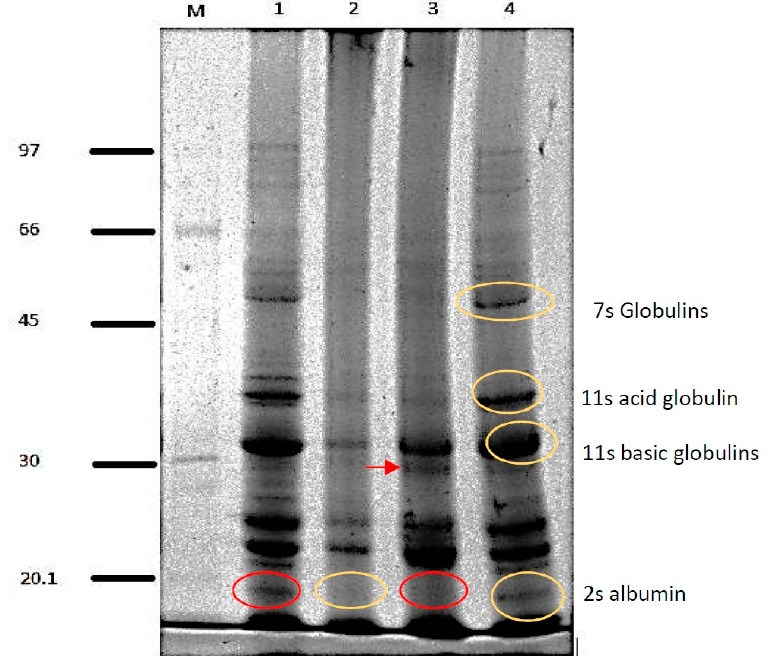
Figure 1. Sodium dodecyl sulfate polyacrylamide gel electrophoresis (SDS-PAGE) of Pasankalla (QP) and Willd (QW) protein isolates with and without transglutaminase (TG). M: Molecular weight marker; 1: QW protein isolate; 2: QP protein isolate 3: QW protein isolate + TG; 4: QP protein isolate + TG. The arrow in lane 3 shows a protein band appearing after TG addition to WP.